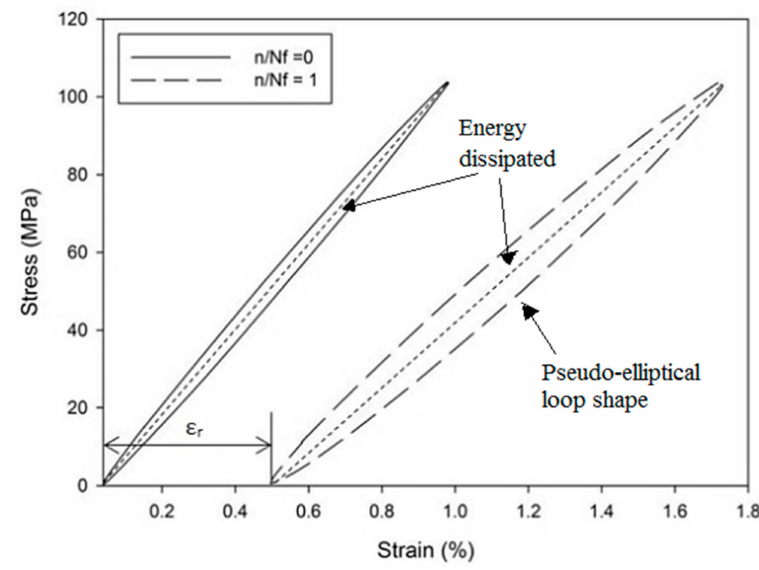
Figure 4. First and final hysteresis loop of PCCP_09045 tested at 0.75